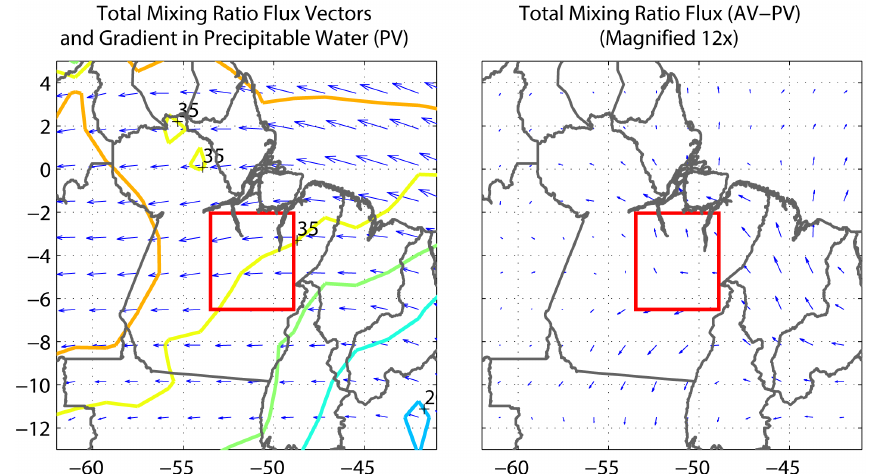
Figure 13. Left panel: map of vertically integrated total water advective flux vectors (quivers) and vertically integrated precipitable water (contours) for the potential vegetation case (PV), region near the Pará site, September 2003. Quivers are scaled and convey only directionality and relative magnitude. Contours of low precipitable water are shown by cool colors (blues) and high precipitable water with warm colors (reds). Right panel: the differential in vertically integrated advection of total precipitable water, actual vegetation minus potential vegetation (AV–PV). Quivers are scaled to 12 times relative to the left panel. In both panels the sub-domain bounding the Pará focus region is shown with a red box.